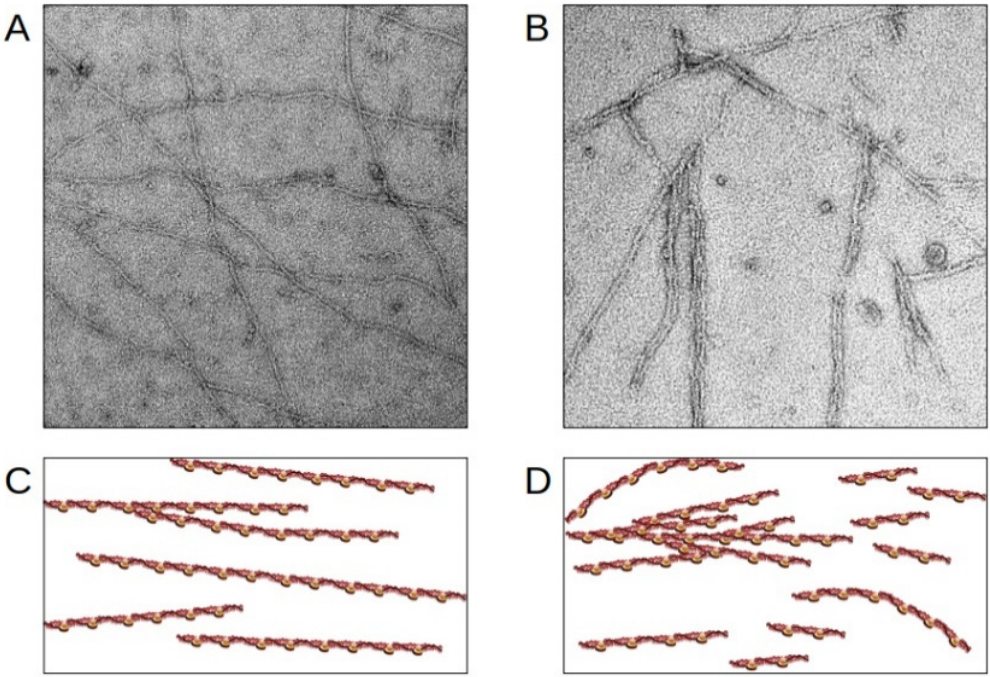
Figure 5. Disruption of thin filaments induced by RCM cTnI-variants. ( A , B ) Electron microscopic images obtained with reconstituted cardiac thin filaments. ( C , D ) schematic presentation. ( A , C ) wild-type cTnI; ( B , D ) the RCM cTnI-variant p.R170W leads to shortened, wavy and partially aggregated thin filaments. The figure was created using PowerPoint (Microsoft).